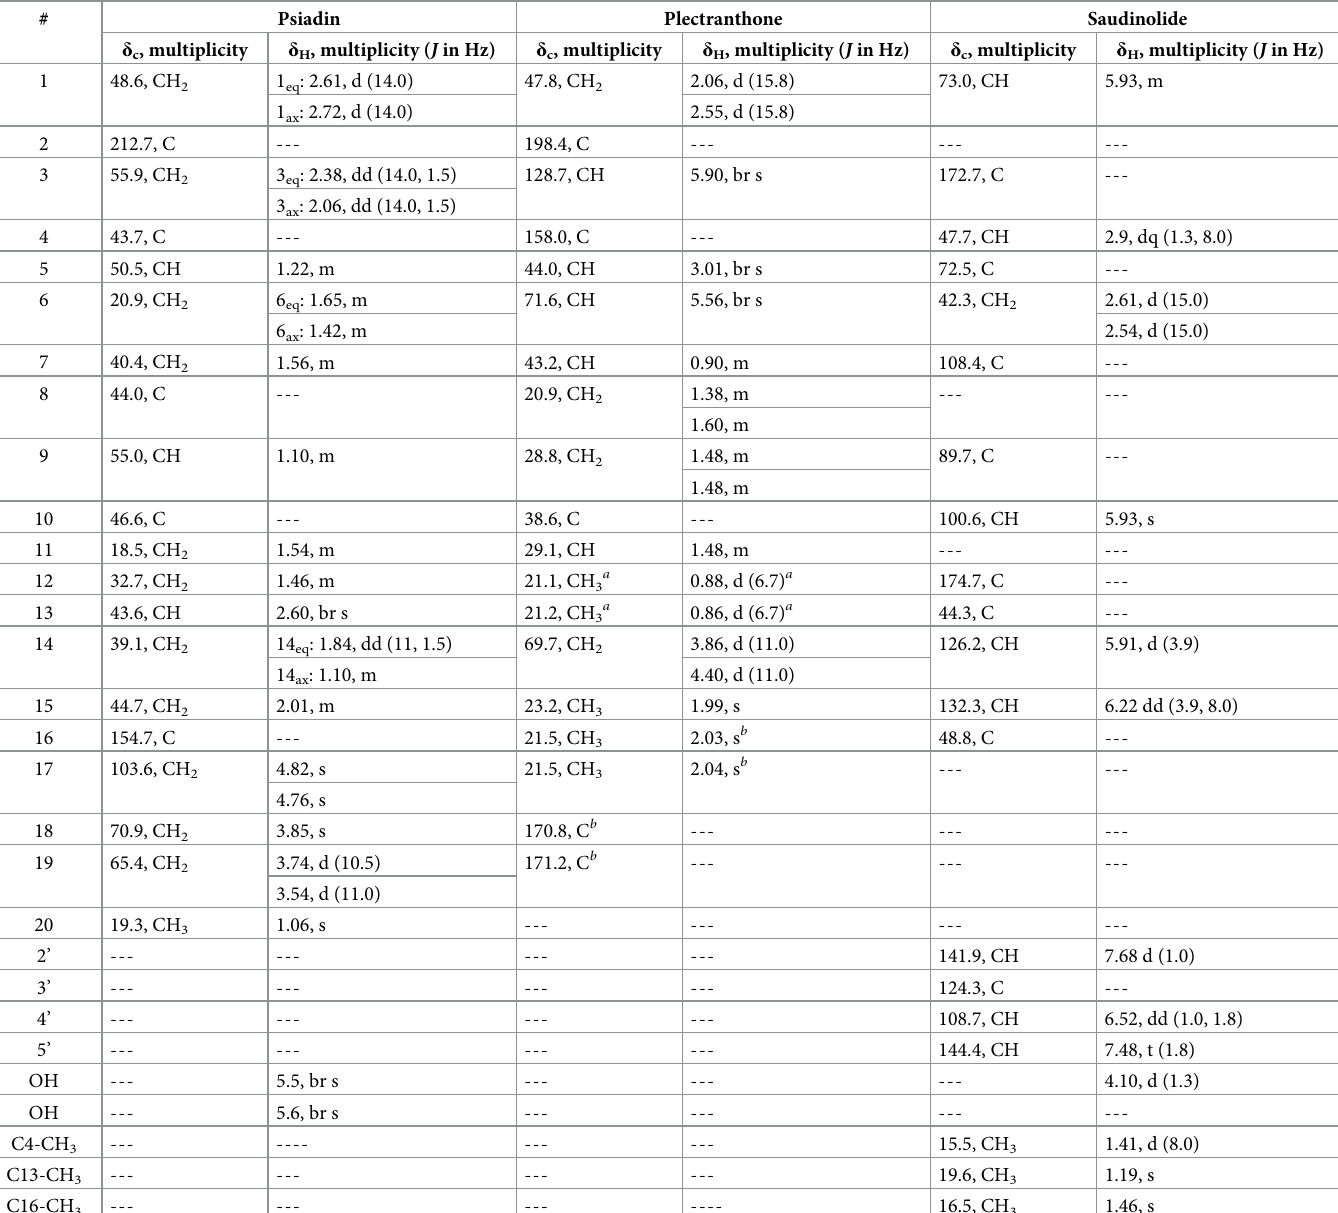
Table 1. 1 H and 13 C NMR data (CDCl 3 ) of psiadin, plectranthone and